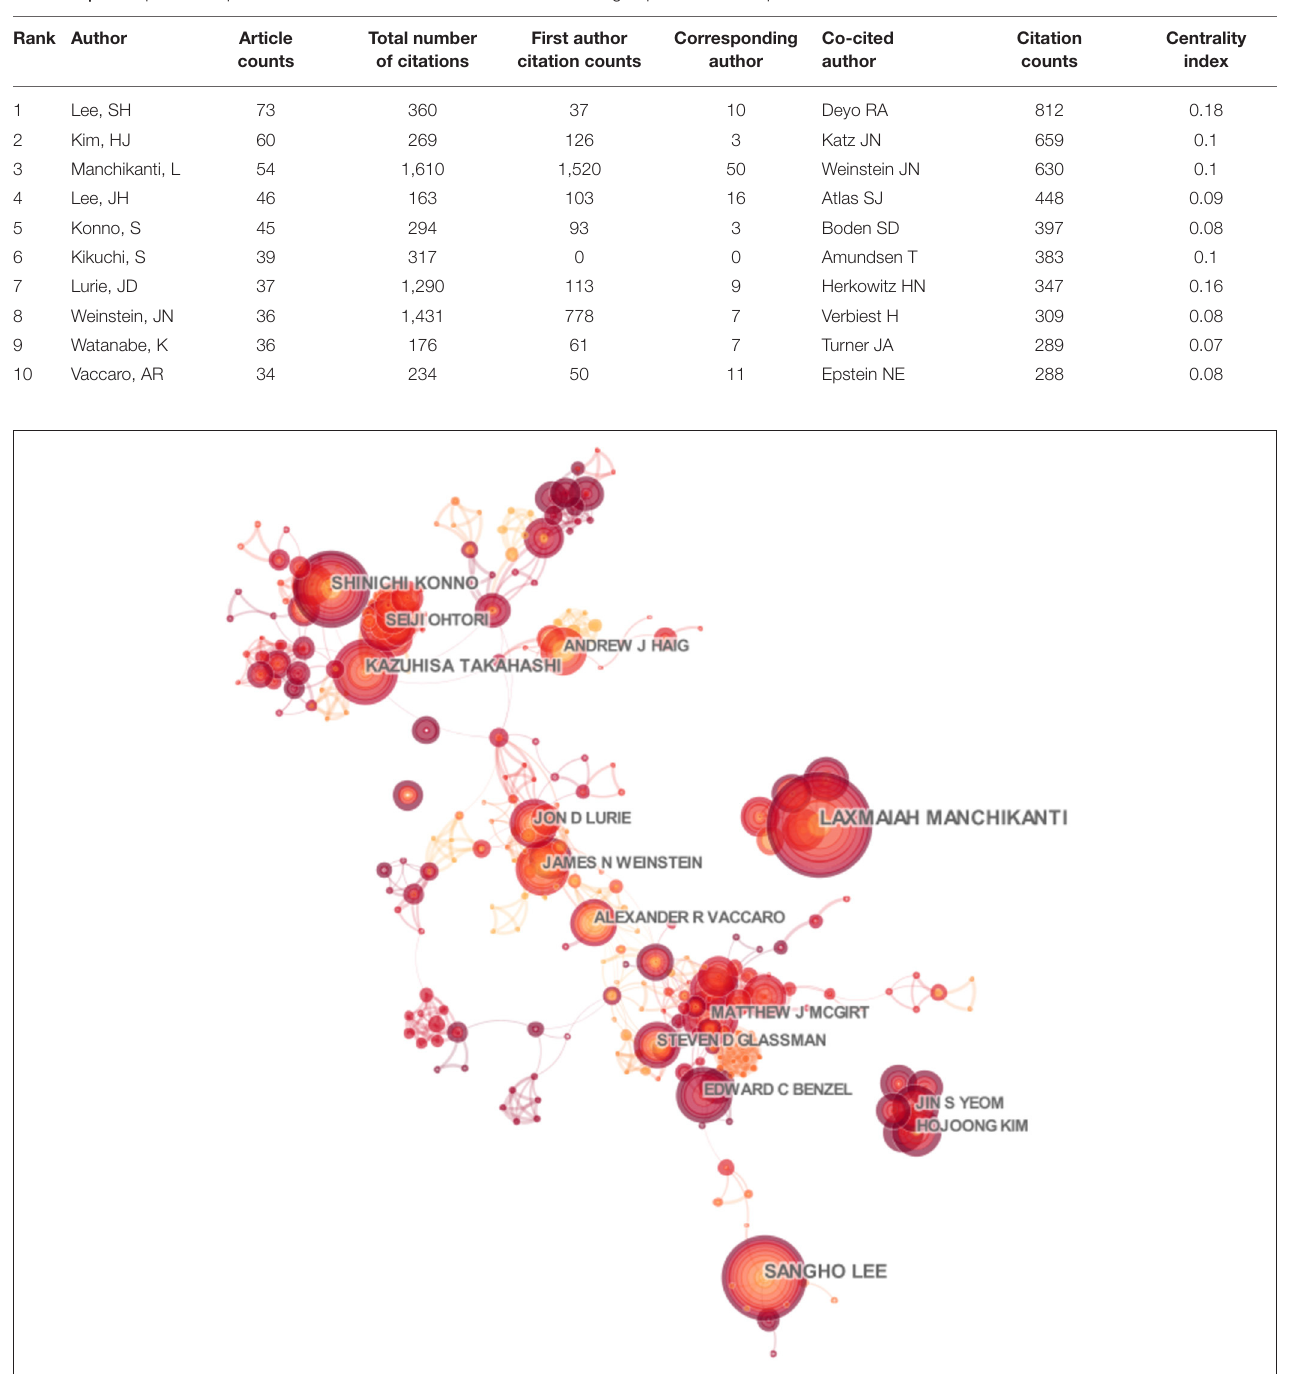
TABLE 3 | The top 10 most productive authors and co-cited authors contributing to publications in spinal stenosis research.